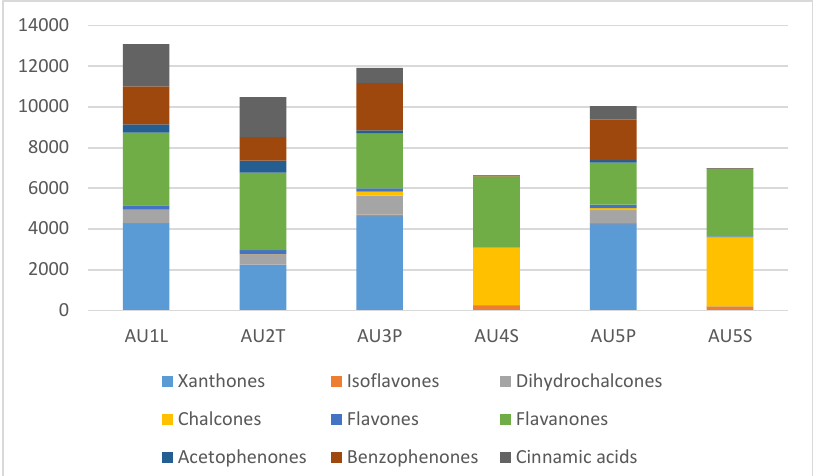
Figure 9. Composition of classes of compounds (as a sum of the concentrations in mg/kg) in various plant parts of Cyclopia aurescens (AU1-5, all from Klein Swartberg, refer to Table 2) (L = leaves, T = twigs, P = pods, S = seeds). Leaves, twigs and pods are chemically diverse and have a similar combination of compounds whilst the seeds contain mainly chalcones and flavanones.